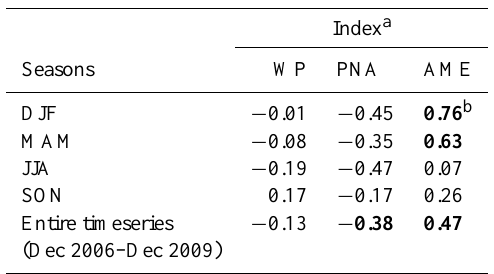
Table 4. Correlations of WP, PNA and AME index defined in the text with the Asian anthropogenic sulfate AOD at 70 ◦ N averaged between 120 ◦ E and 180 ◦